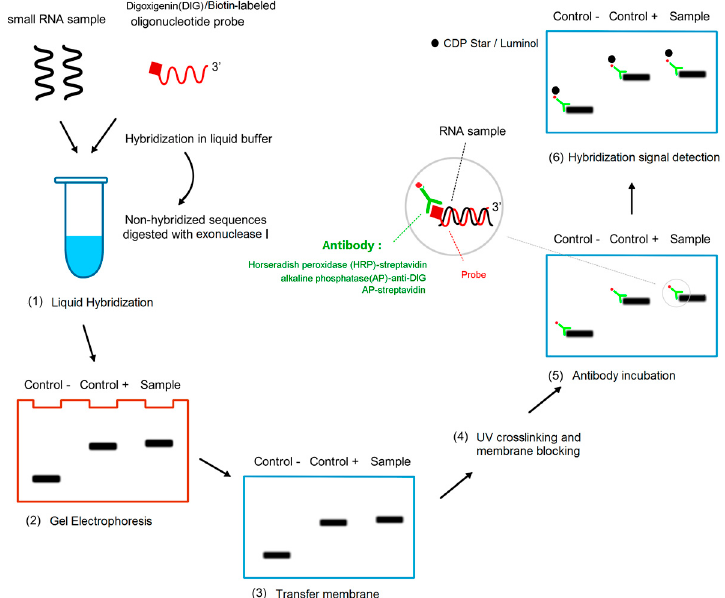
Figure 1. Schematic diagram of procedures of liquid hybridization and solid phase detection (LHSPD). ( 1 ) Liquid hybridization: The small RNA samples, hybridization buffer, and probe are mixed in a tube